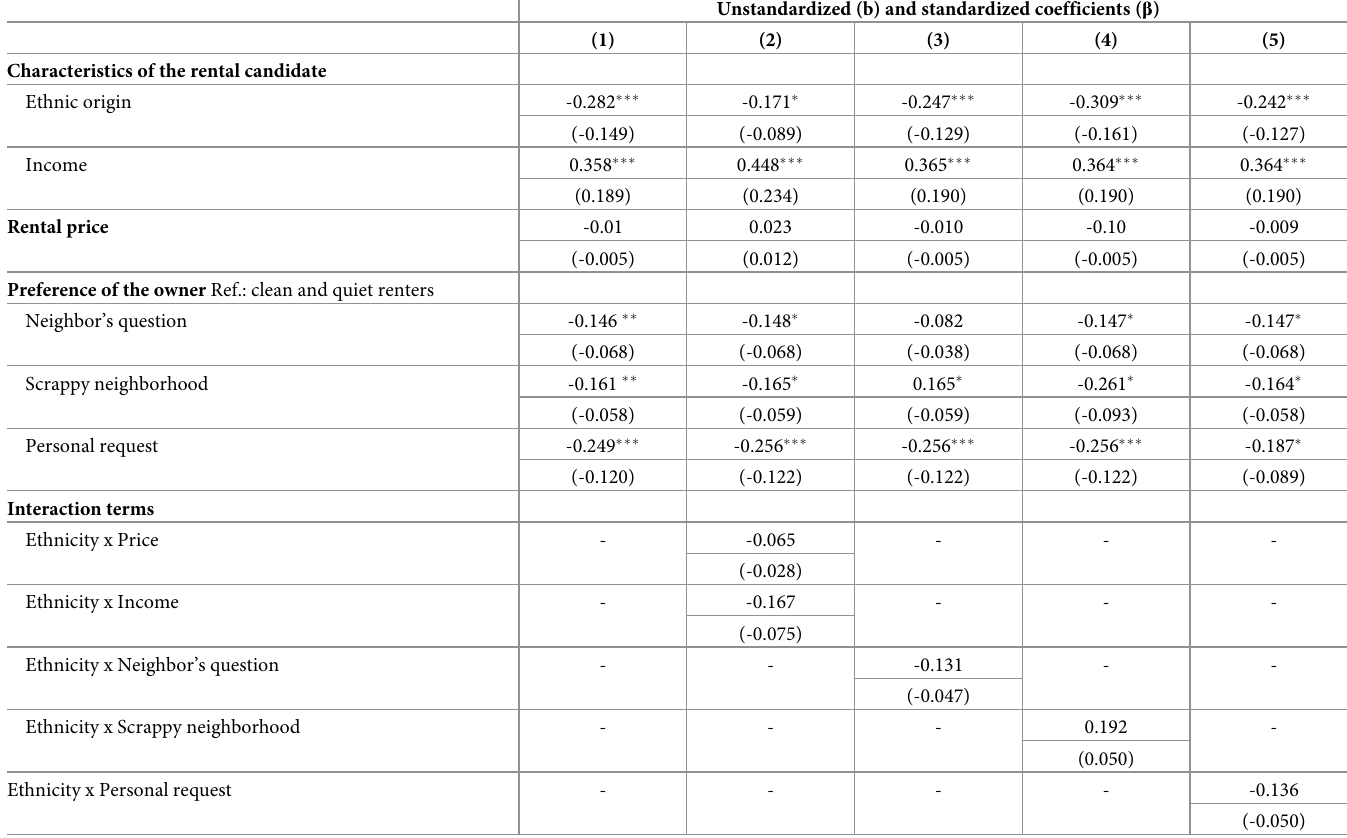
Table 3. Linear regression analyses of the agent taste-based